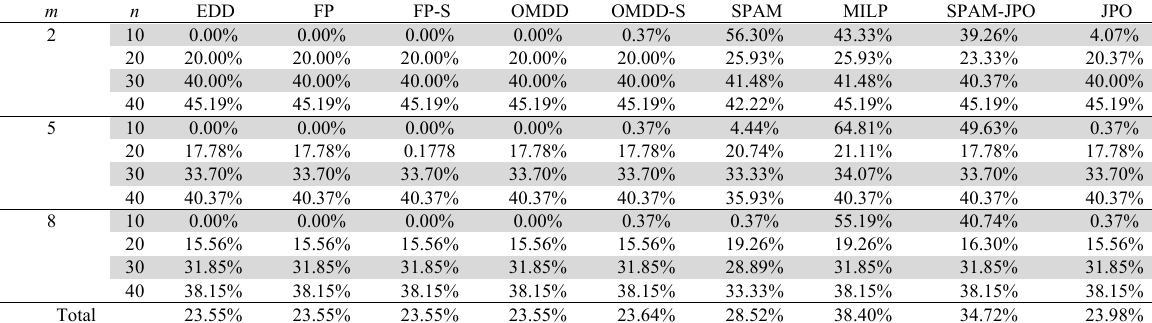
Large-sized test instances: % of optimality for m and